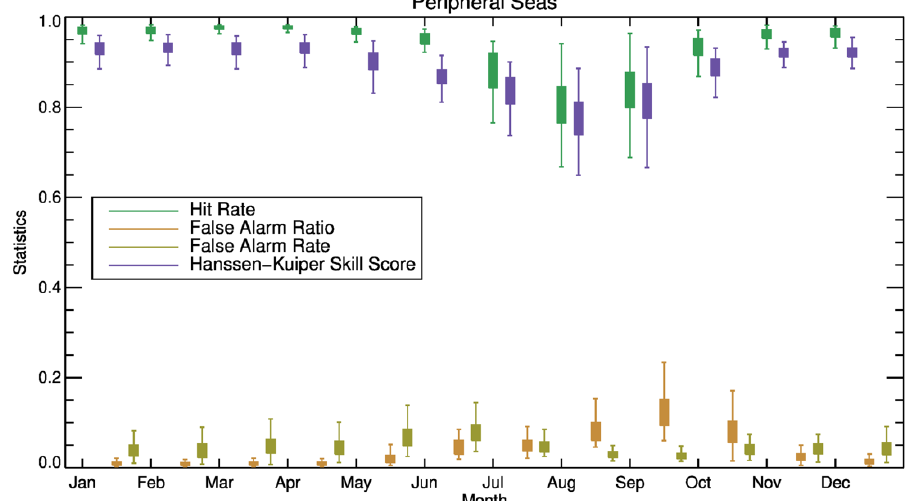
Figure 7. Same as Figure 6, except over the Peripheral Seas of the Arctic Ocean, including the Beaufort, Chukchi, East Siberian, Laptev, and Kara and Barents Seas. Table 2. Monthly median Hit Rate, False Alarm Ratio, False Alarm Rate, and Hanssen-Kuiper Skill Score over the Arctic Ocean poleward of 60 North and over the Peripheral Seas of the Arctic Ocean. Monthly Median